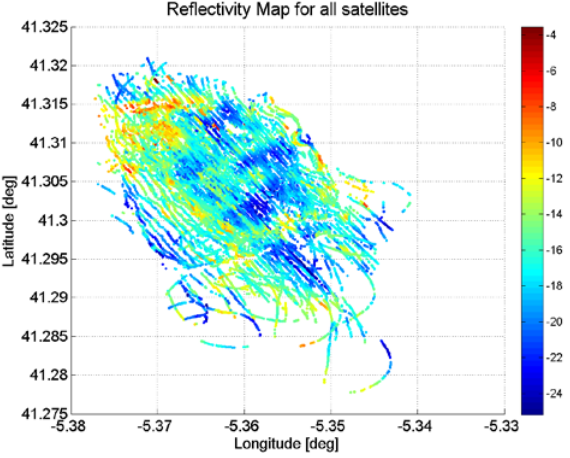
Figure 3. Preliminary reflectivity map from